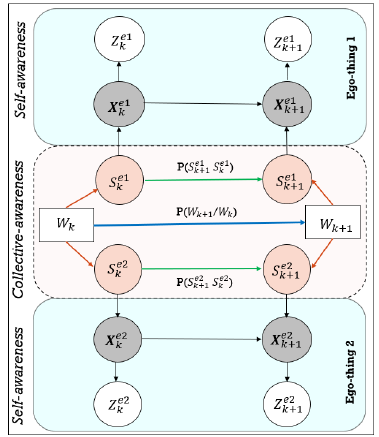
Figure 2. Generative dynamic Bayesian network (GDBN) model for a two ego-thing network: The cyan and orange shaded area of the model represents self-awareness and collective-awareness. Horizontal and vertical arrows represent the probabilistic connection between the variables and different abstraction